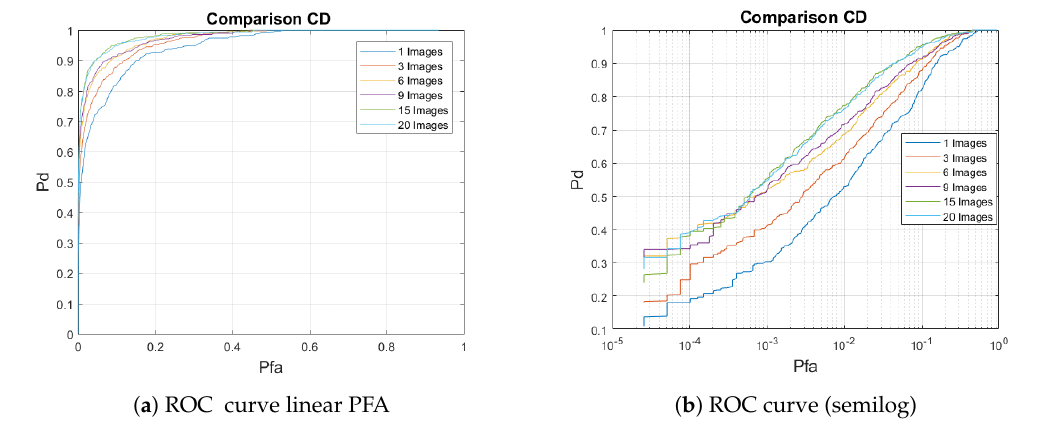
Figure 9. ROC (Receiver Operating Characteristic) curves representing PD (probality of detection) and PFA (probabiblity of false alarm) for different amounts of images used to create the FBR scene.